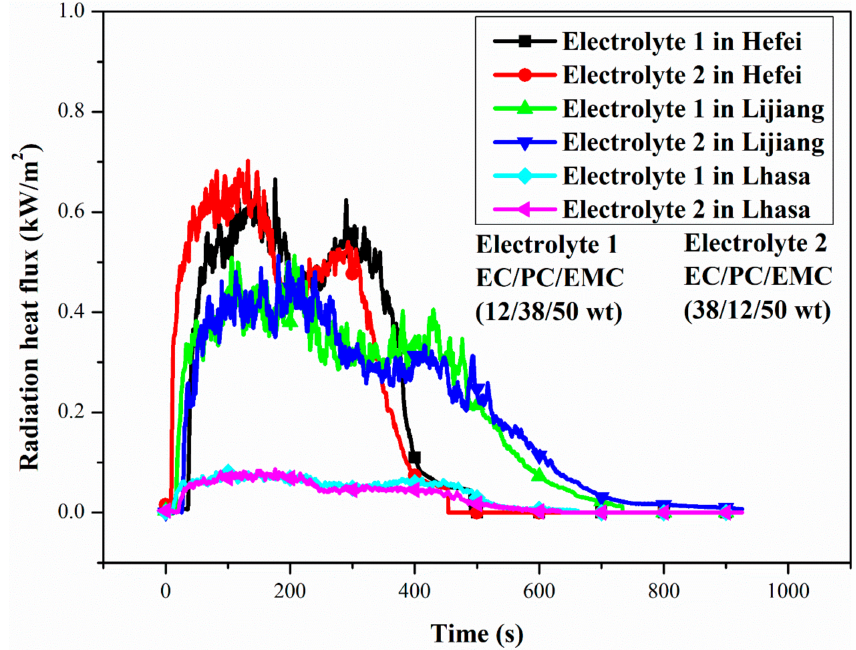
Figure 9. Radiation heat flux of two electrolytes burning in Hefei (100.09 kPa), Lijiang (76.11 kPa) and Lhasa (65.23